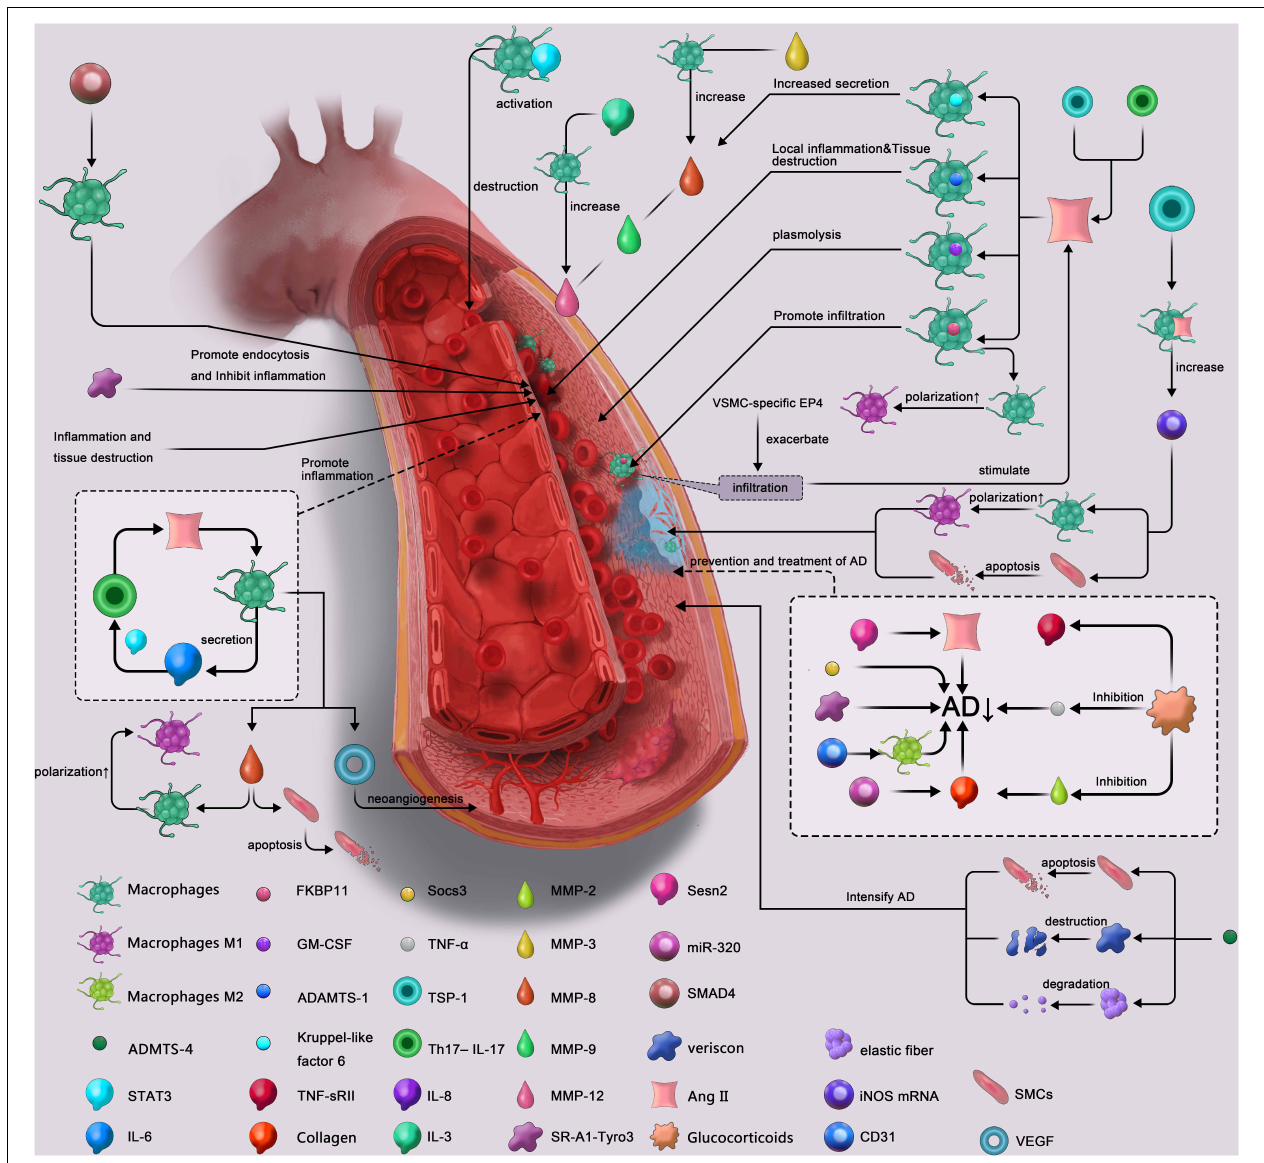
FIGURE 2 | Summarize diagram of the role of macrophage in aortic dissection. AD ↓ , reduces the incidence of aortic dissection; ADAMTS, a disintegrin and metalloproteinase with thrombospondin motifs; STAT, signal transducer and activator of transcription; IL, Interleukin; GM-CSF, granulocyte macrophage-colony-stimulating factor; TNF-sR II, tumor necrosis factor receptor II; Socs 3, suppressor of cytokine signaling 3; TNF, tumor necrosis factor; TSP-1, thrombospondin 1; Th17-IL-17, T helper cell 17-interleukin -17; MMP, matrix metalloproteinase; SR-A1-Tyro3, A1 scavenger receptor-Tyro3 axis; miRNA, microRNA; Ang II, angiotensin II; iNOS mRNA, inducible nitric oxide synthase mRNA; SMCs, smooth muscle cells; VEGF, vascular endothelial growth